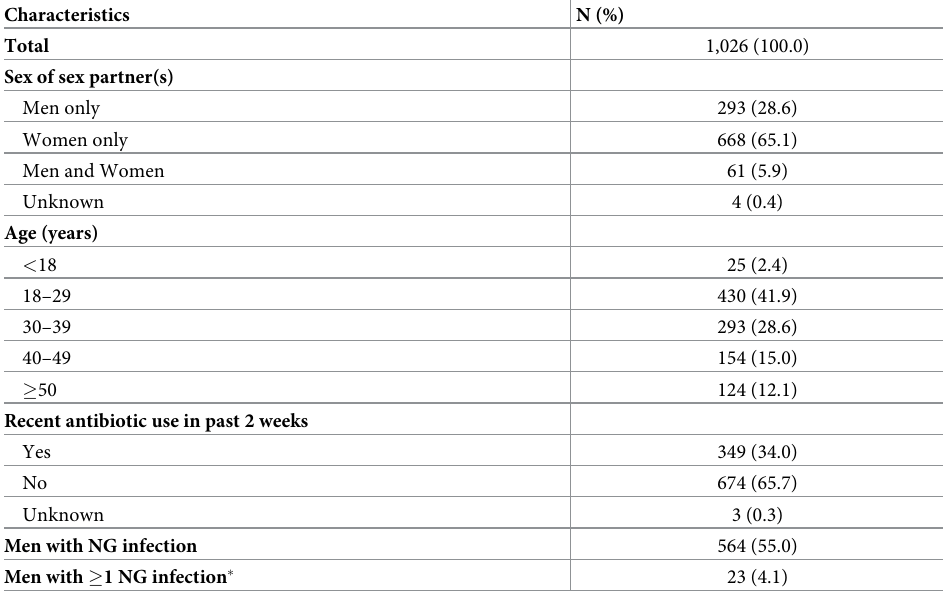
Table 2. Characteristics of men with urethritis enrolled in EGASP Thailand, November 2015 –October 2016 (n = 1,026).